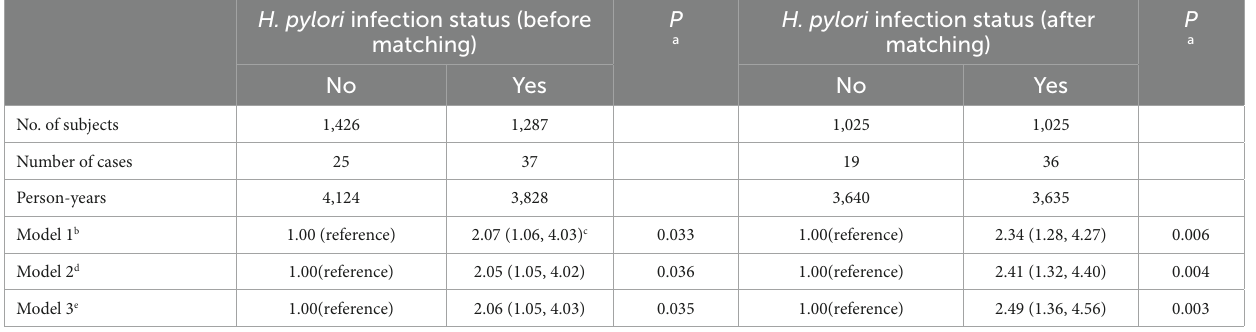
TABLE 2 Association between Helicobacter pylori infection status and subclinical hyperthyroidism before and after matching in women.